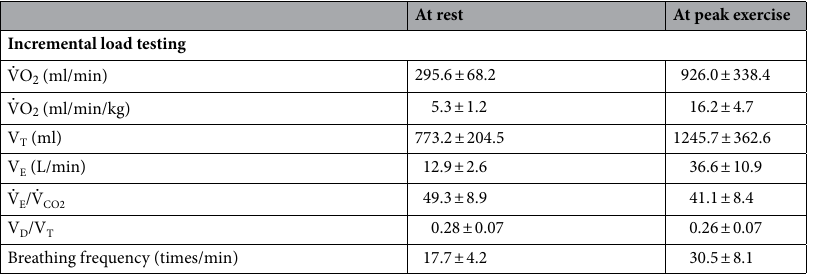
˙ V ˙ V E / CO2 ventilatory equivalent for carbon dioxide, V D /V T dead space to